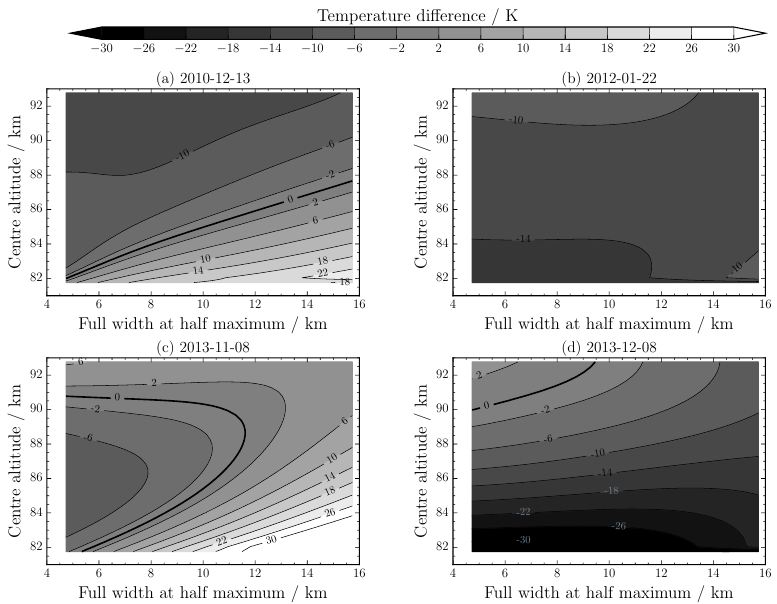
Figure 2. Nightly mean temperature difference between GRIPS 9 and artificial OH ∗ (3–1) temperatures from the Na lidar at ALOMAR for the same days shown in Fig. 1. Temperature difference is shown as (cid:52) T (z,d) = T OH ∗ ( 3 − 1 ) − T z,d and is a function of chosen centre altitude and full width at half maximum. Weighted temperatures are calculated despite possibly missing data at the boundaries. Positive values indicate that GRIPS 9 measured an apparently warmer temperature than observed by the lidar for the given parameters. The 0-contour line indicates exact agreement. Measurement durations are given in Fig.